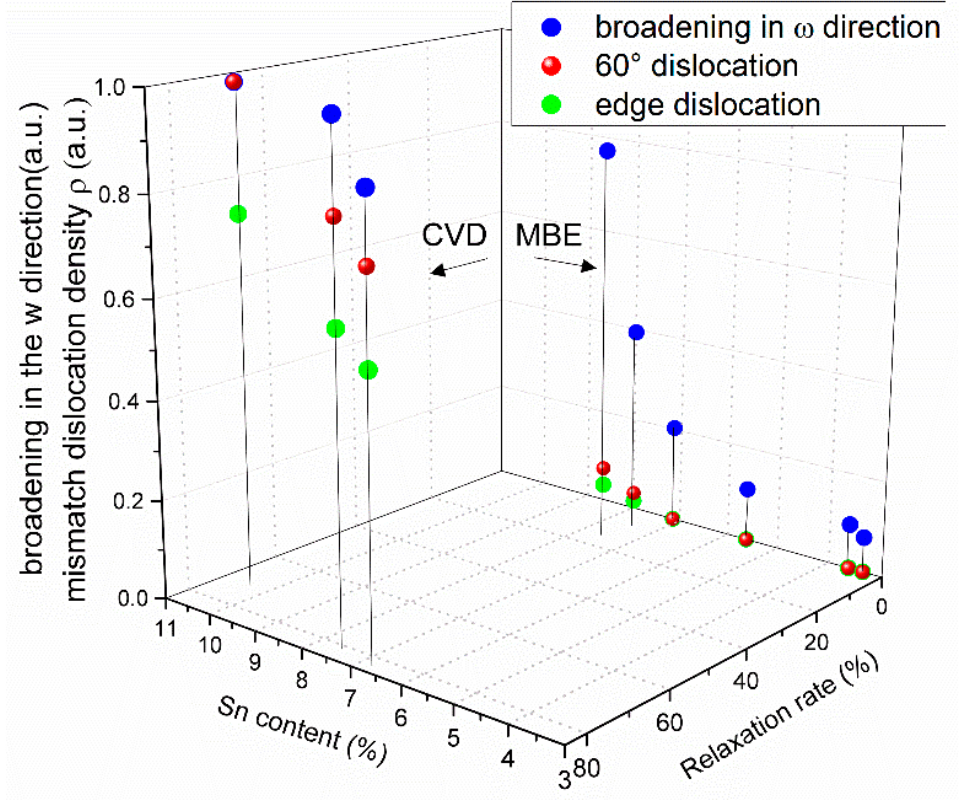
Figure 5. Normalized broadening in the ω direction (blue), and the dislocation density calculated based on all 60° dislocation (red) and all edge dislocation (green) assumption with different Sn contents and relaxations.